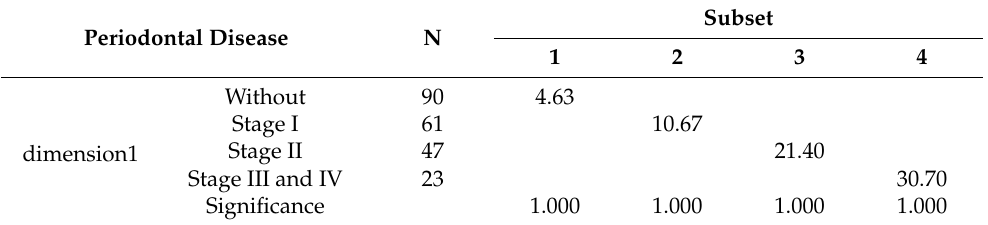
Table 3. The Gabriel test for comparing the different stages of periodontal disease. Periodontal Disease